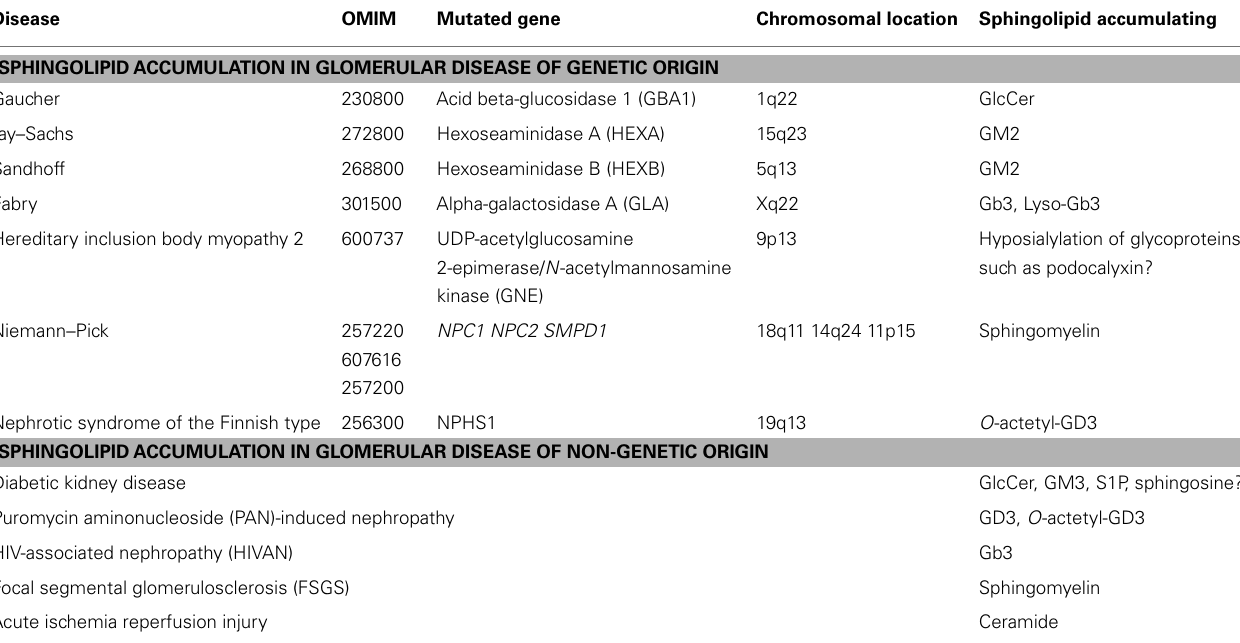
Table 1 | Sphingolipid accumulation in glomerular diseases of genetic and non-genetic origin .